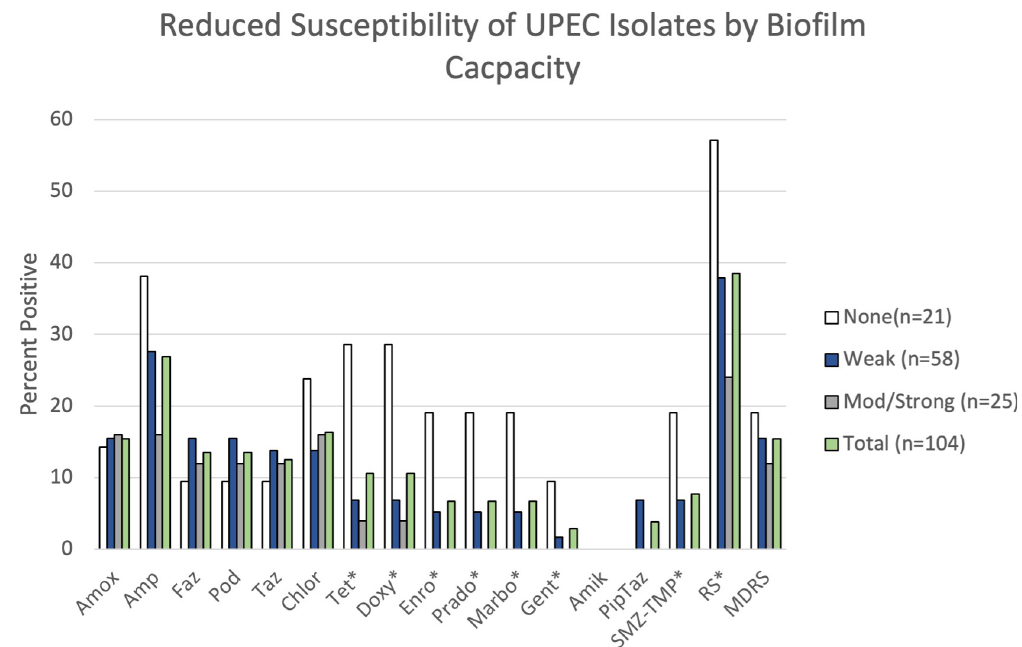
Fig 2. Phenotypic reduced susceptibility of UPEC isolates to 15 antimicrobials. Percentage of isolates with reduced susceptibility (RS) to the 15 antimicrobials tested stratified by biofilm capacity. Asterisk ( � ) indicate RS phenotypes that were negatively associated with biofilm formation (P < 0.10) prior to correcting for multiple comparisons. Amox = Amoxicillin- clavulanic acid; Amp = Ampicillin; Faz = Cefazolin; Pod = Cefpodoxime; Taz = Ceftazidime; Chlor = Chloramphenicol; Tet = Tetracycline; Doxy = Doxycycline; Enro = Enrofloxacin; Marbo = Marbofloxacin; Prado = Pradofloxacin; Gent = Gentamicin; Amik = Amikacin; PipTaz = Piperacillin Tazobactam; SMZ-TMP = Trimethoprim Sulfamethoxazole; RS = Reduced susceptibility; MDRS = Multidrug reduced